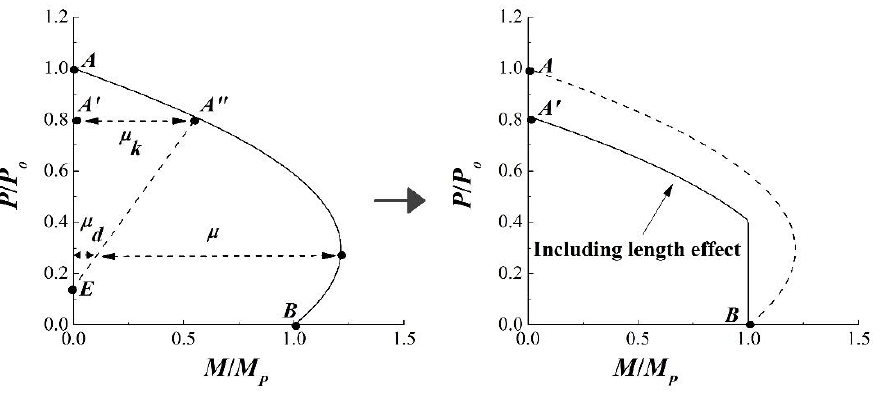
Figure 18. Interaction curve form EC4.